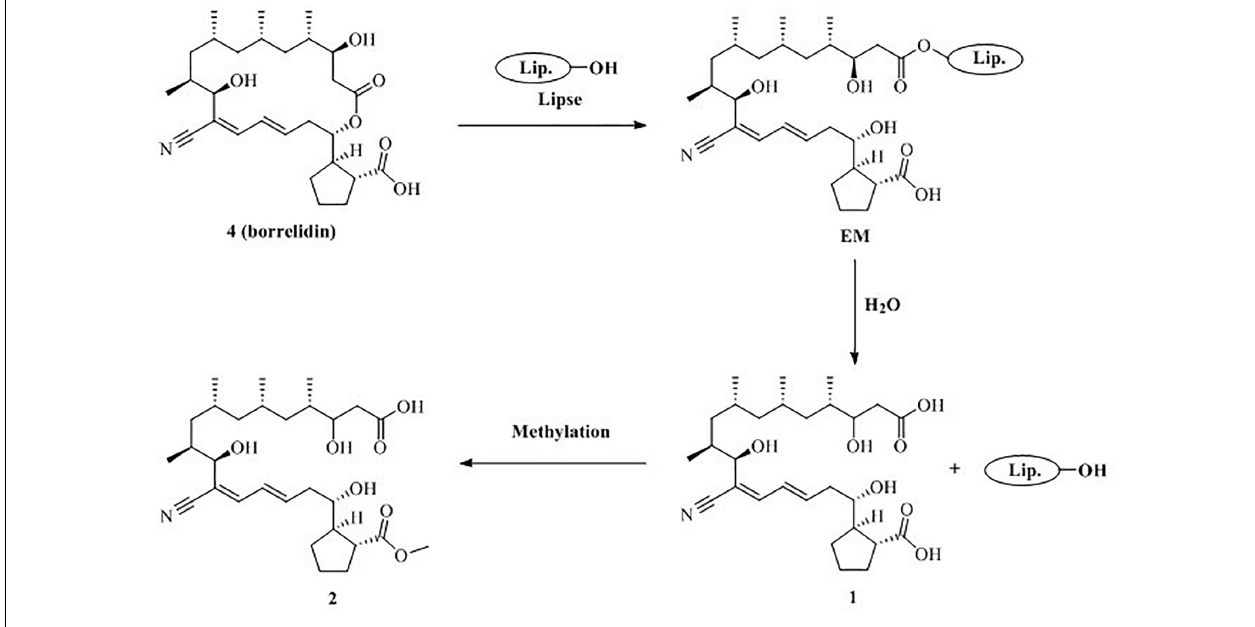
FIGURE 6 | Proposed formation mechanism for 1 and 2